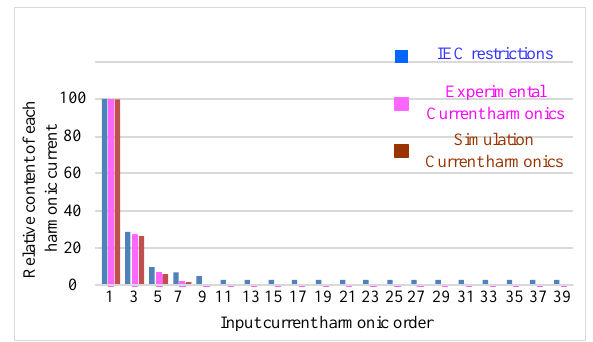
Figure 21. The experimental frequency spectrum of the input current compared with IEC and sim- ulation.